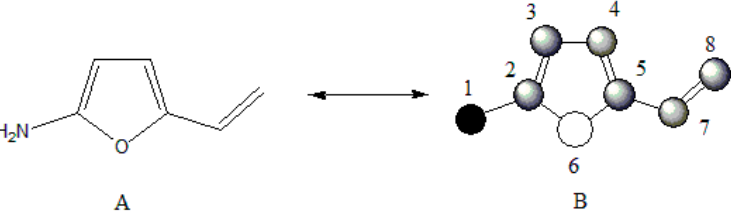
Figure 3. ( A ) Molecular structure of 2-amino-5-vinylfurane; ( B ) Corresponding graph with arbitrary numeration.